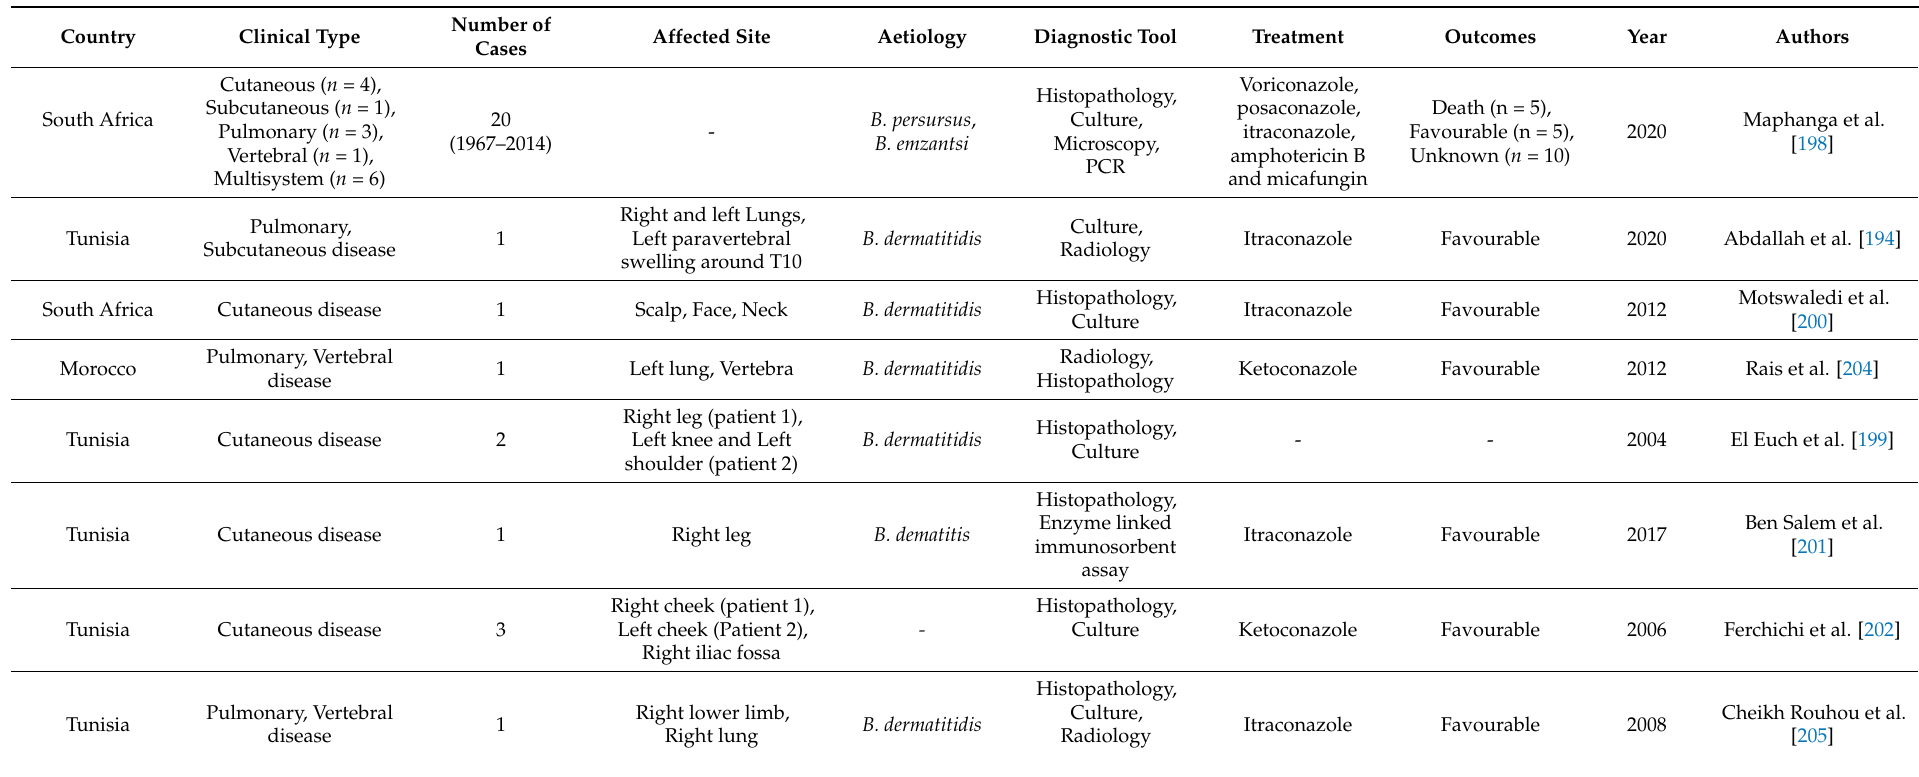
Table 9. Studies published on Blastomycosis in